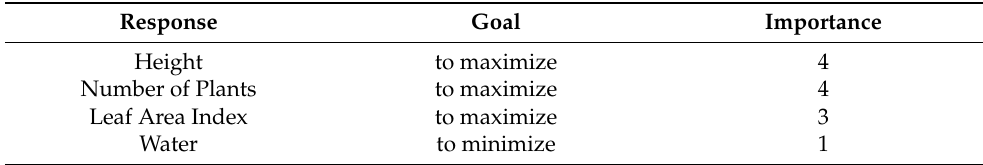
Table 5. Desirability function parameters employed for each period of growth. Response Goal Importance Height to maximize 4 Number of Plants to maximize 4 Leaf Area Index to maximize 3 to